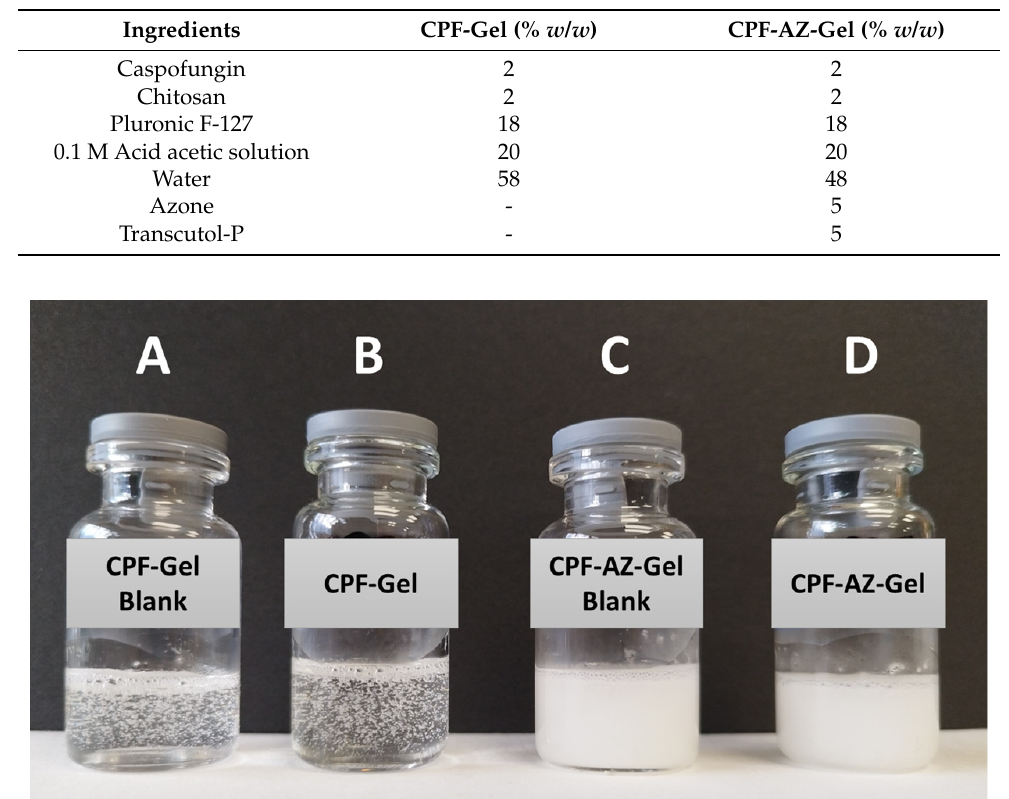
Figure 3. Photograph of drug-loaded hydrogels and nondrug-loaded hydrogels. ( A ) CPF-Gel without drug; ( B ) CPF-Gel; ( C ) CPF-AZ-Gel without drug, and ( D ) CPF-AZ-Gel. The gelling of CPF-gel and CPF-AZ-gel occurs because of the Pluronic F-127 and chi- tosan content. In an aqueous solution, the amphiphilic properties of Pluronic F-127 cause self-aggregation-forming micelles at concentrations above its critical micelle concentration, where PPO hydrophobic groups interact together via van der Waals forces to form the inner core, whereas the PEO hydrophilic groups interact with water molecules via hydrogen bonds to form the outer shell [29,30]. Consequently, gelation occurs at sufficient concentra- tions of Pluronic F-127, which, in this study, was 18% due to micelles packing [31]. On the other hand, the gelling with chitosan was produced by physical cross-linking, where ion interactions and hydrogen bonds are the driving forces for the formation of the entangled networks of this gel [32,33]. Figure 4 illustrates the mechanism of hydrogel